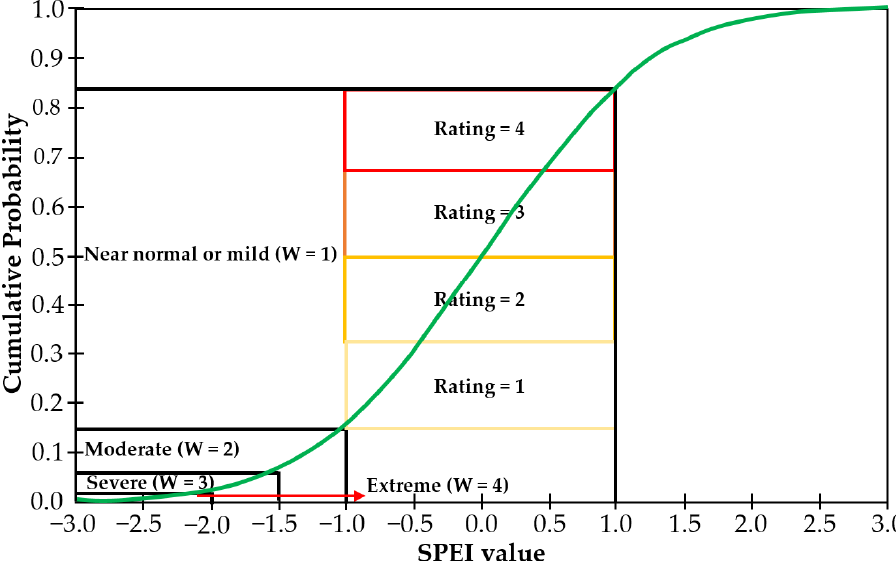
Figure 2. Weights and rating scores based on cumulative distribution function of SPEI for the calculation of Drought Hazard Index (DHI).